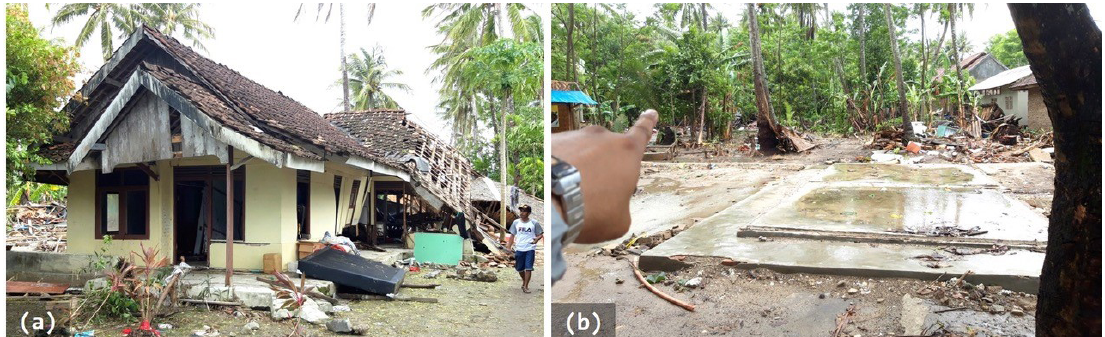
Figure 13. Examples of damage at wooden houses: (a) major damage and (b) complete damage or washed away.